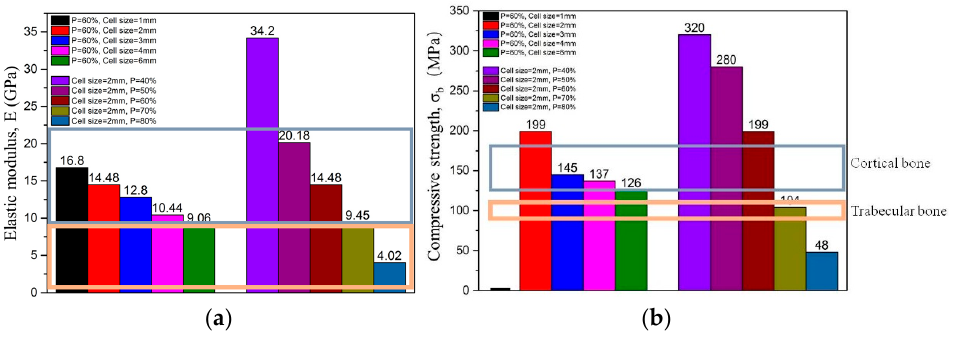
Figure 9. ( a ) Change of static elastic modulus of porous structures with porosity and unit cell size; ( b ) change of compressive strength of porous structures with porosity and unit cell size.